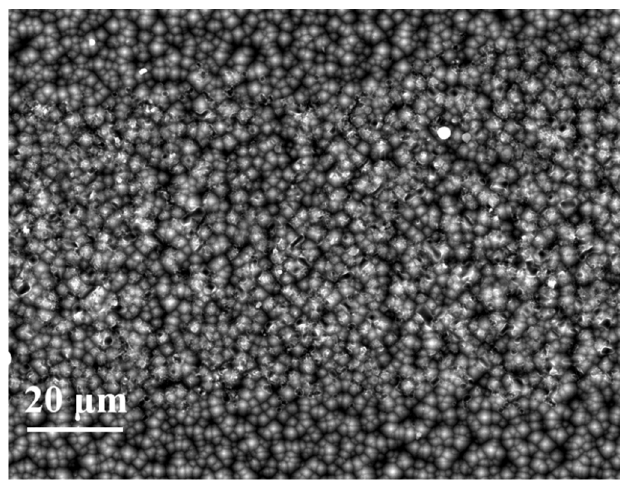
Figure 18. Si substrate surface etched area SEM images obtained at the Si/metallization interface of Cell 6 after the paste removal.